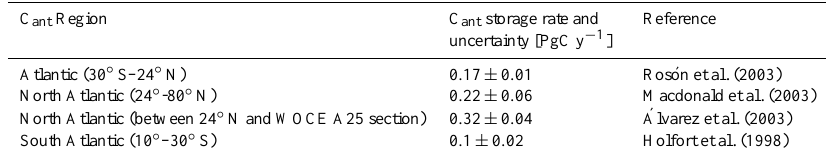
Table A5. Published estimates of C ant storage rate and its uncertainty for different